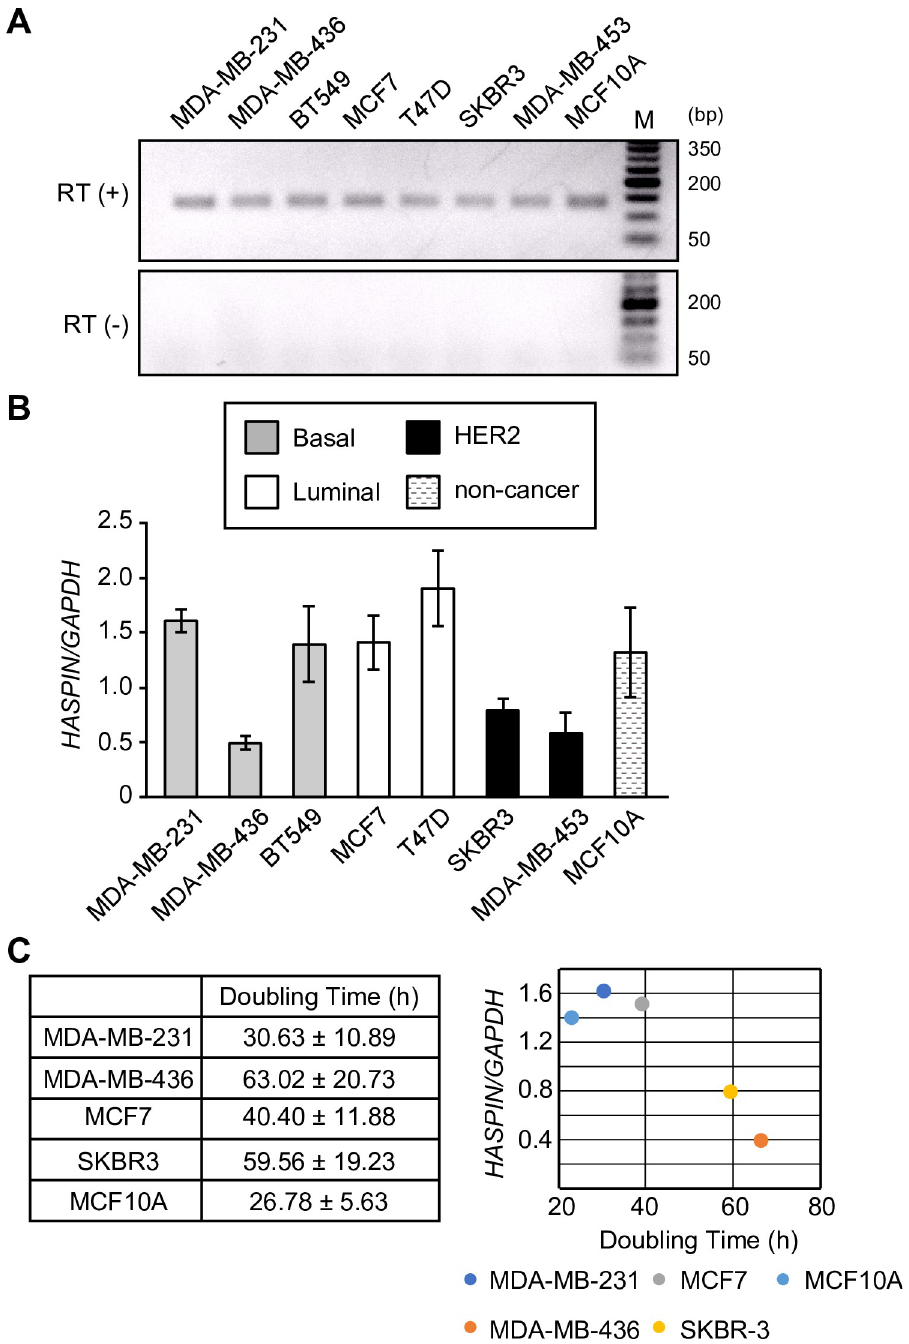
Fig 1. HASPIN mRNA levels in breast cancer cell lines. (A) Agarose electrophoresis confirming the specificity of the primer pair in RT (+) (top) and the absence of genomic DNA contamination in RT ( − ) (bottom). (B) Quantification of HASPIN mRNA levels in breast cancer cell lines and MCF10A cells. Data are presented as the mean ± SD of three independent experiments. (C) Doubling times ± SD (hours) of breast cancer cells and MCF10A cells (left panel). Data are presented as the mean ± SD of three independent experiments. Pearson’s correlation coefficient between HASPIN expression level and doubling time in breast cancer cells (r = − 0.913, P < 0.05, right panel).